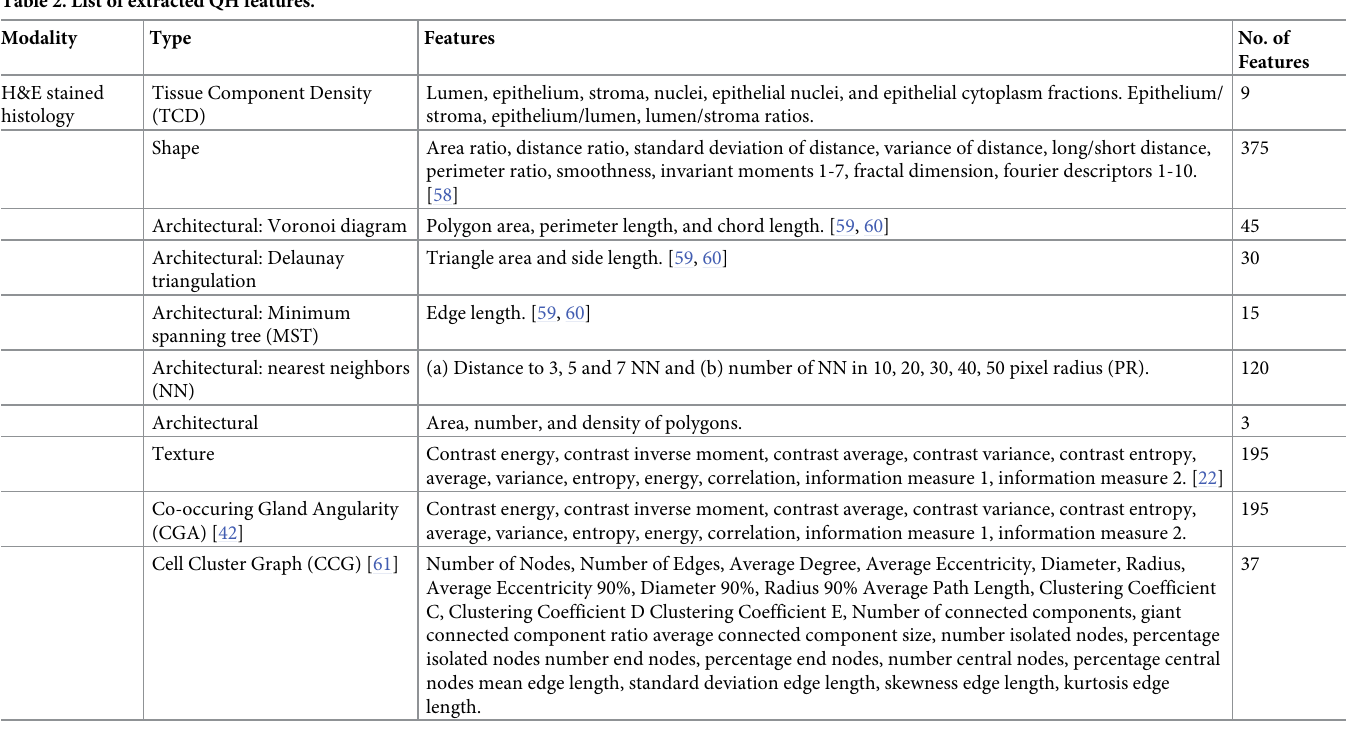
Table 2. List of extracted QH